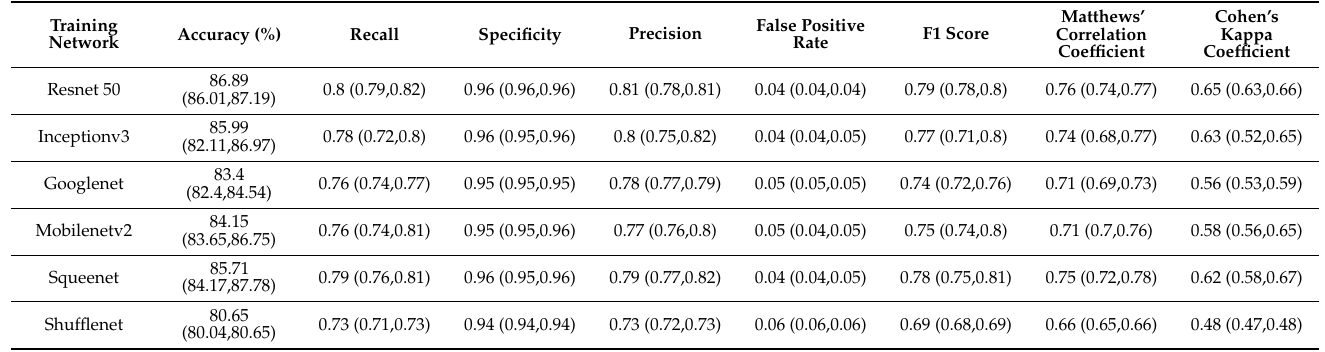
Table 4. The global evaluation metrics when considering 5-fold cross validation (mean value, min value, and max